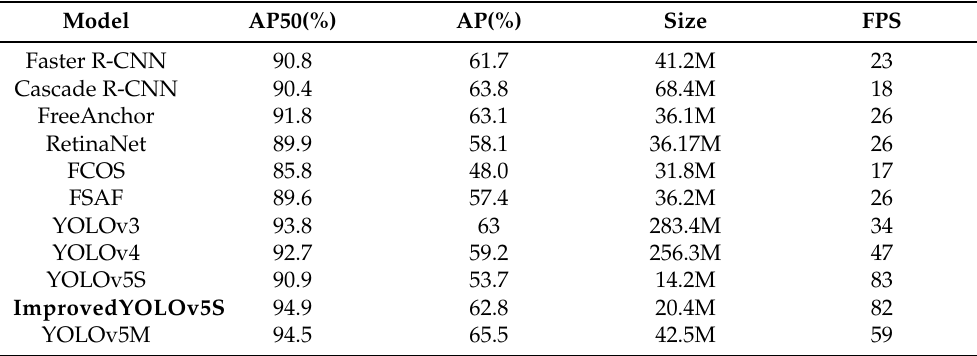
Table 3. Comparison of experimental results of improved algorithms on test